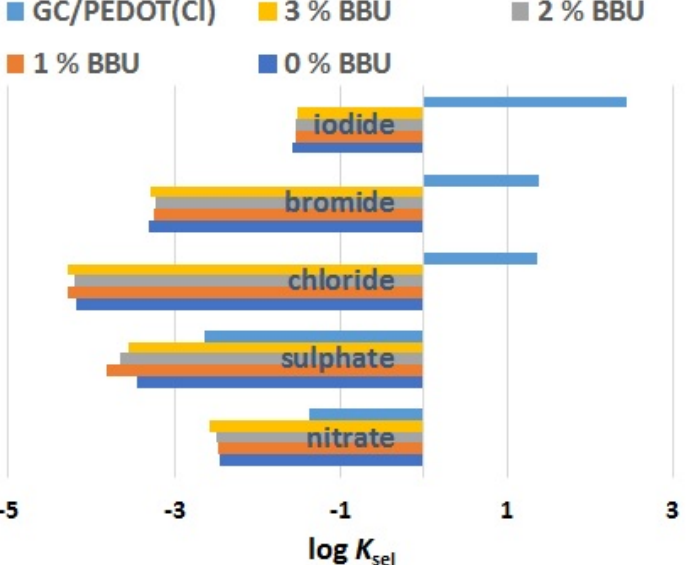
Figure 5. Selectivity coefficients for different anions related to perchlorate ISE (log K sel (X − /ClO 4 − )) with different content of BBU in the ISM.